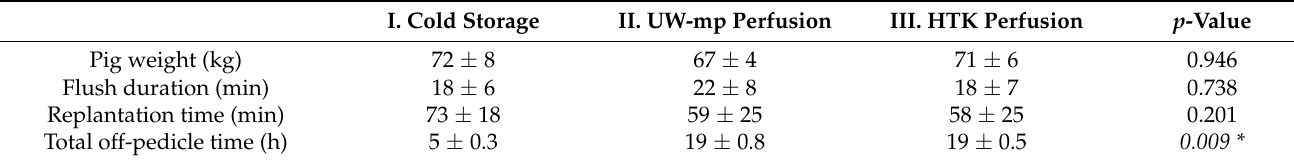
Table 3. Characteristics of the three preservation groups presenting means, standard deviation and p